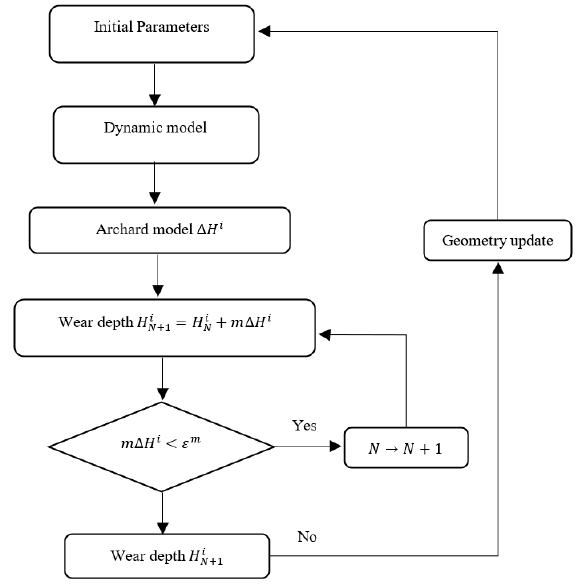
Figure 3. Whole procedure of the dynamic wear prediction model.